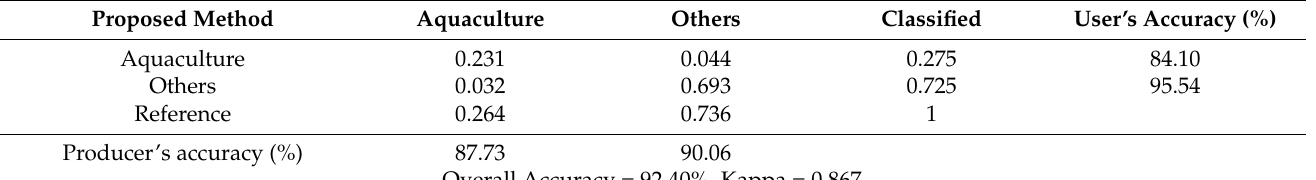
Table 7. Confusion matrix of proposed approach in this study in typical